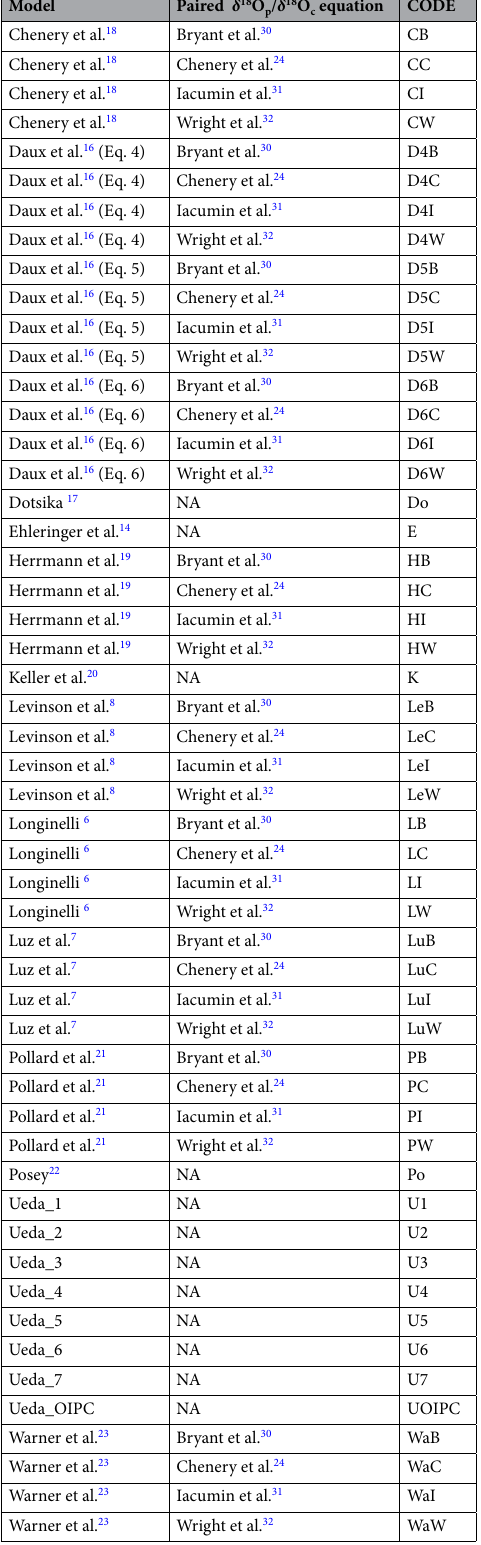
Table 5. Abbreviations for conversion